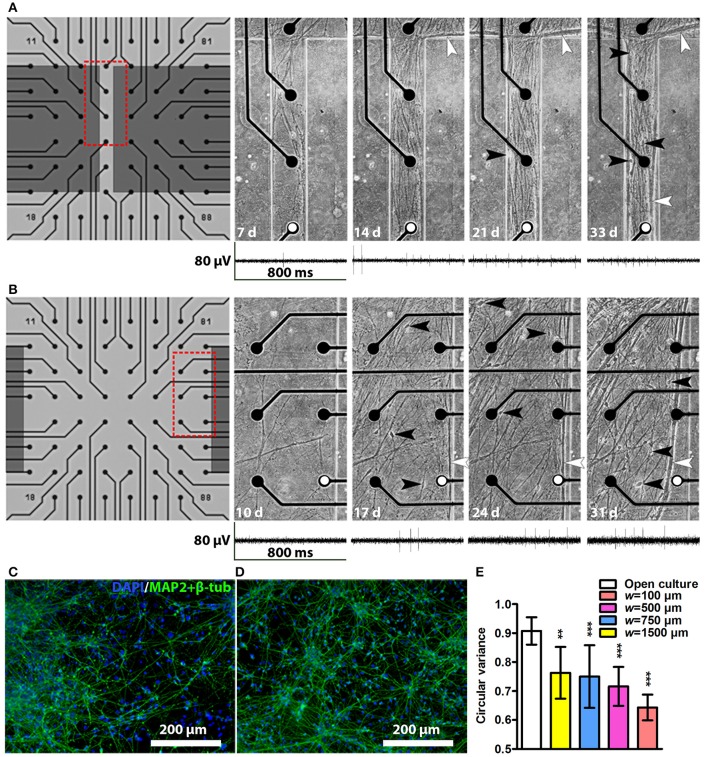
Network development in tunnels and immunocytochemistry images of neuronal cultures. Network development in an h = 43 μm, w = 100 μm tunnel (A) and an h = 43 μm, w = 1,500 μm tunnel (B). The electrode-to-electrode distance is 200 μm. Red dashed boxes in (A,B) show the location of the corresponding subfigures on the right, where somata are indicated by black and neurite bundles by white arrowheads, d, days. Representative MEA traces from the same week are shown under each tunnel image. The electrodes from which the traces were obtained are marked with white dots. Immunocytochemistry images of two cell lines: (C) the hiPSC line 04311.WT and (D) the hESC line 08/023 growing on cell culture controls plates. The cell nuclei (DAPI, blue) and neuronal markers (microtubule-associated protein 2 [MAP2] and class III tubulin [β-tub], green) were stained. (E) Neurite orientation analysis confirmed significantly smaller circular variances of the networks in tunnels than in freely growing open cultures. nopen culture is 8 and n otherwise is 2–7 (Table 1). Statistical difference between the groups was analysed using univariate analysis of variance, and the * symbols indicate significance based on Bonferroni's post hoc test vs. freely growing open cultures (*0.05 > p ≥ 0.01; **0.01 > p ≥ 0.001; ***p > 0.001).